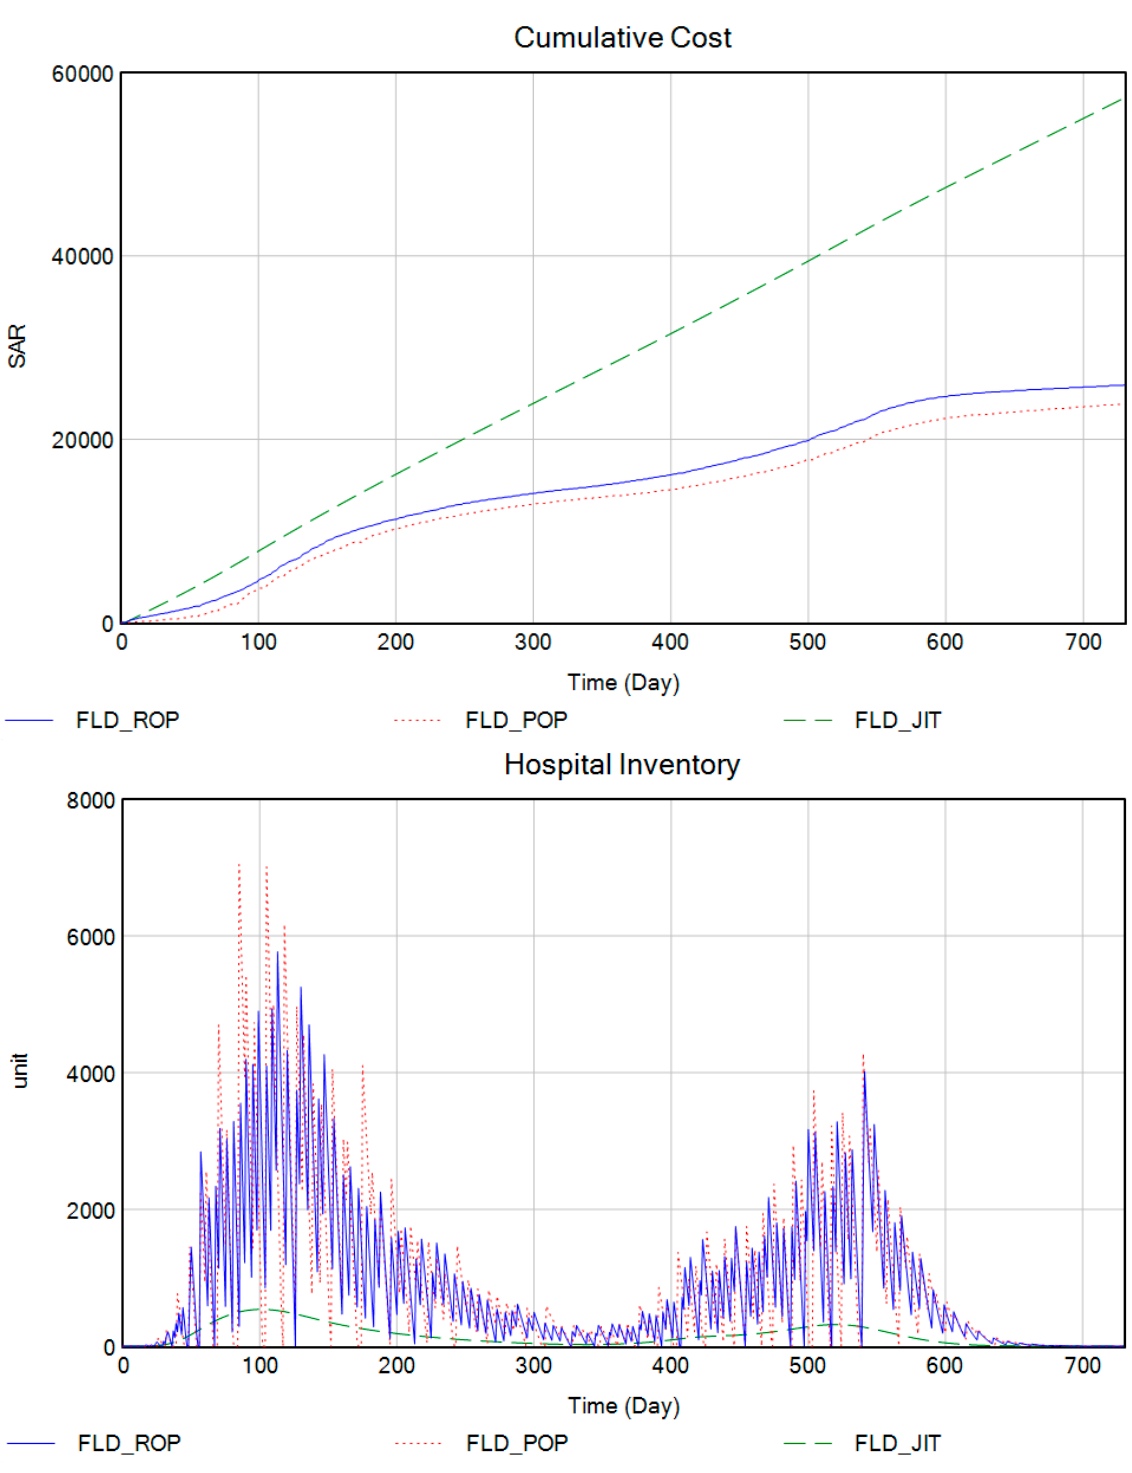
Figure 6. Comparison of inventory policies during FLD.